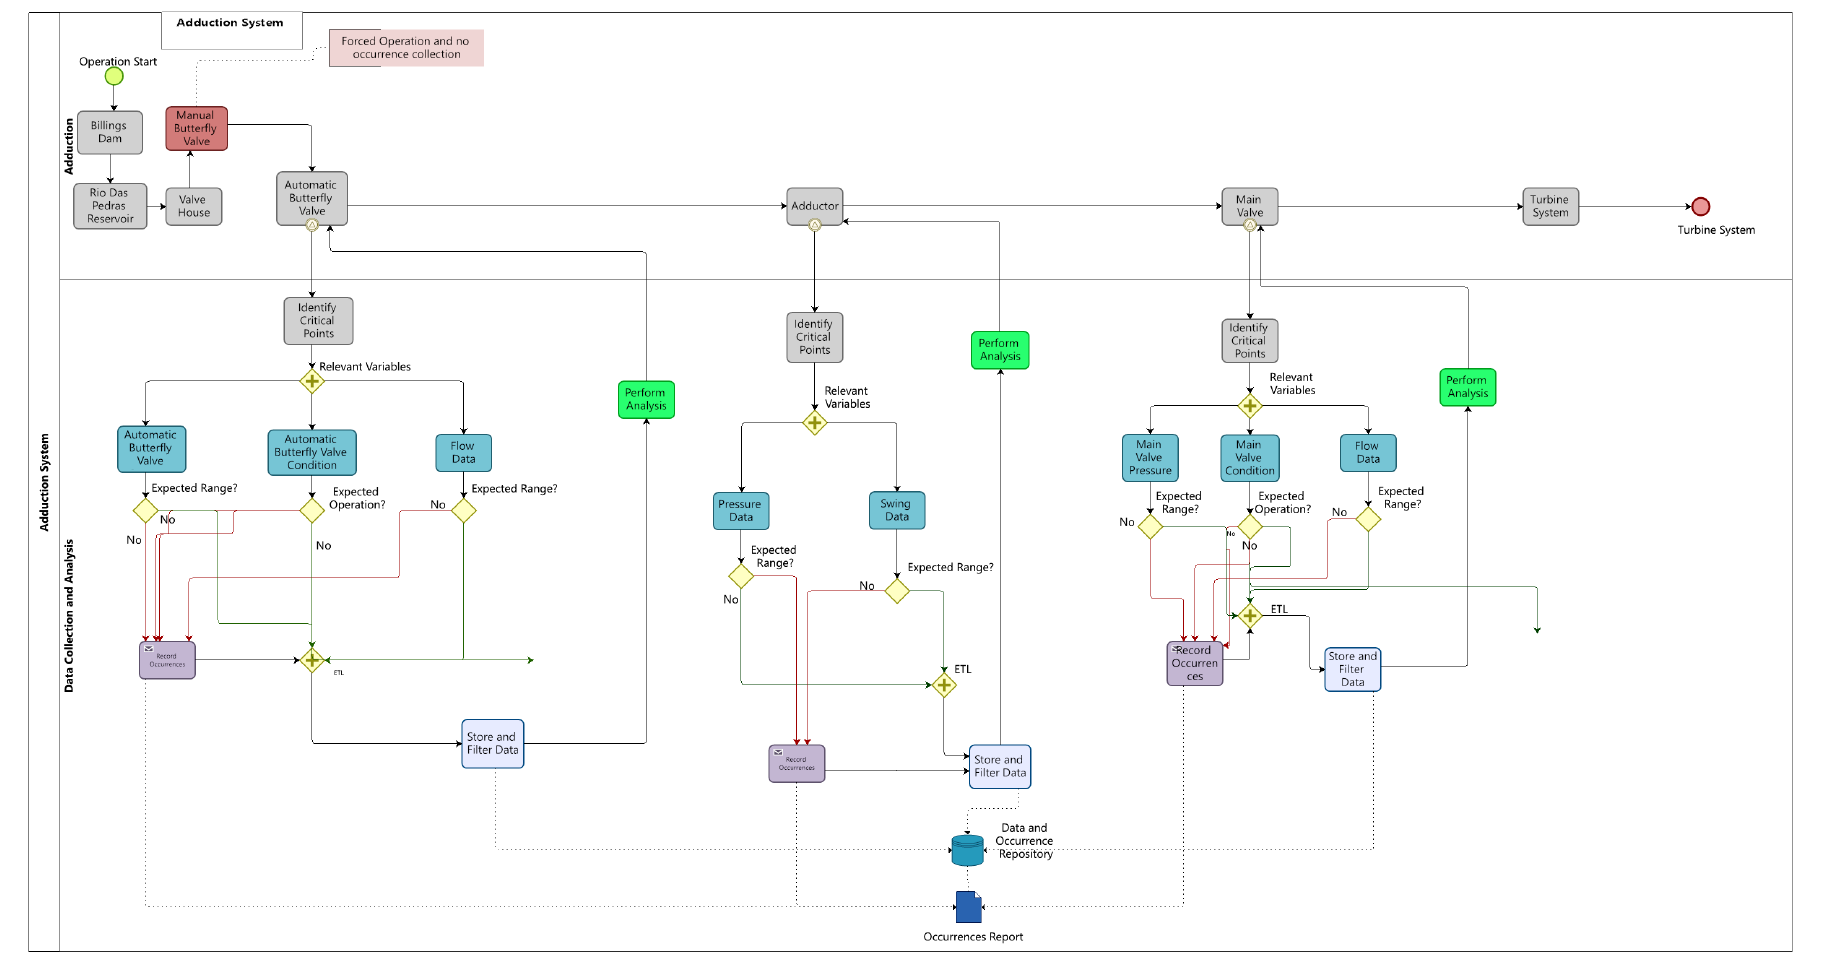
Figure A1. Adduction System